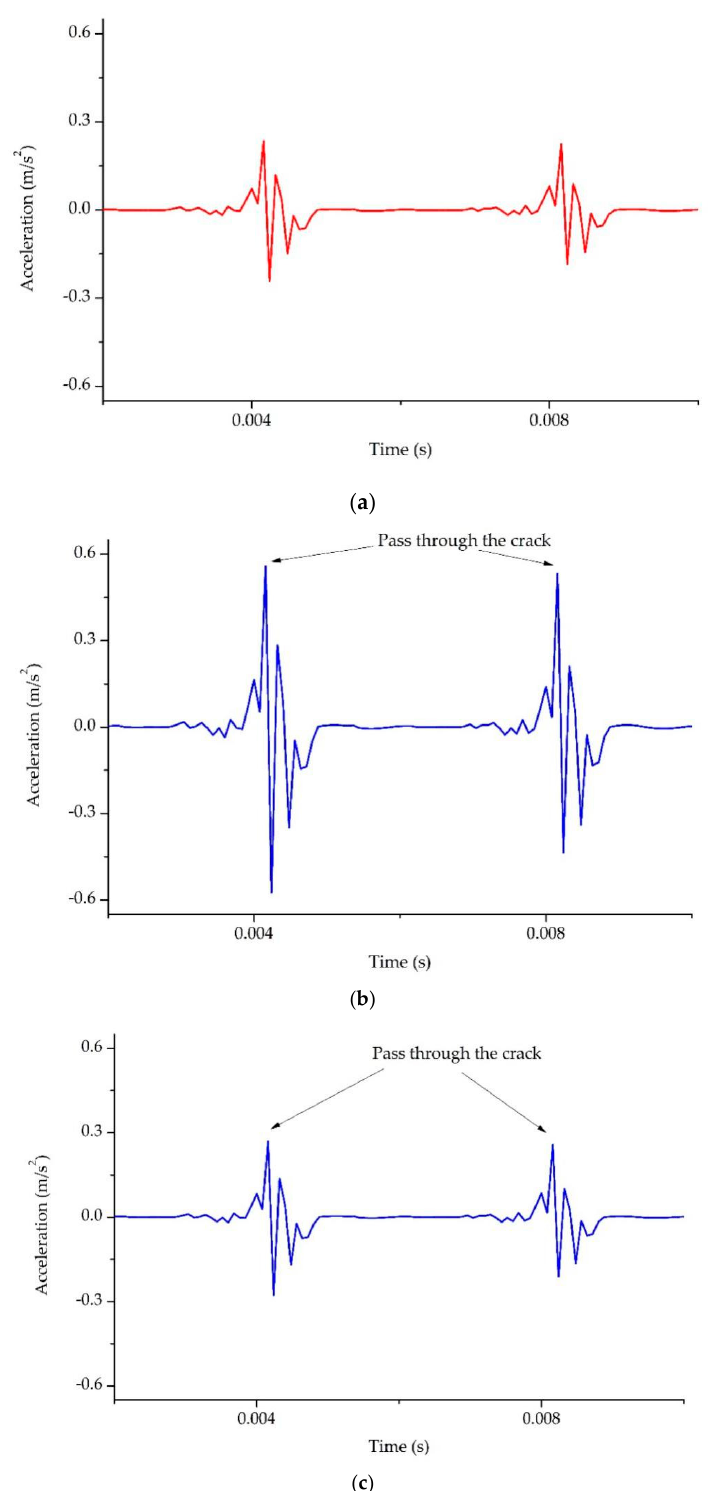
Figure 9. The time domain signals of bearing vibration response with ( a ) spalling faults only ( L = 0.4 mm); ( b ) crack depth potential as the main influencing factor ( a / t = 0.8 c / b = 0.4); ( c ) crack width potential as the main influencing factor ( a / t = 0.4 c / b = 0.8).